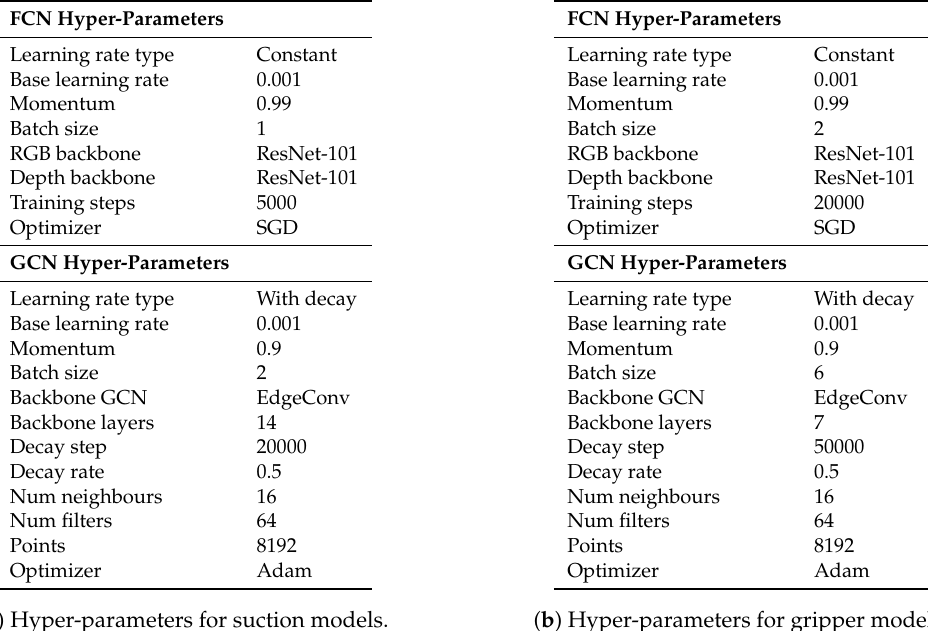
Figure 10. Hyper-parameters for suction and gripper Fully Convolutional Network (FCN) and Graph Convolutional Network (GCN) models.